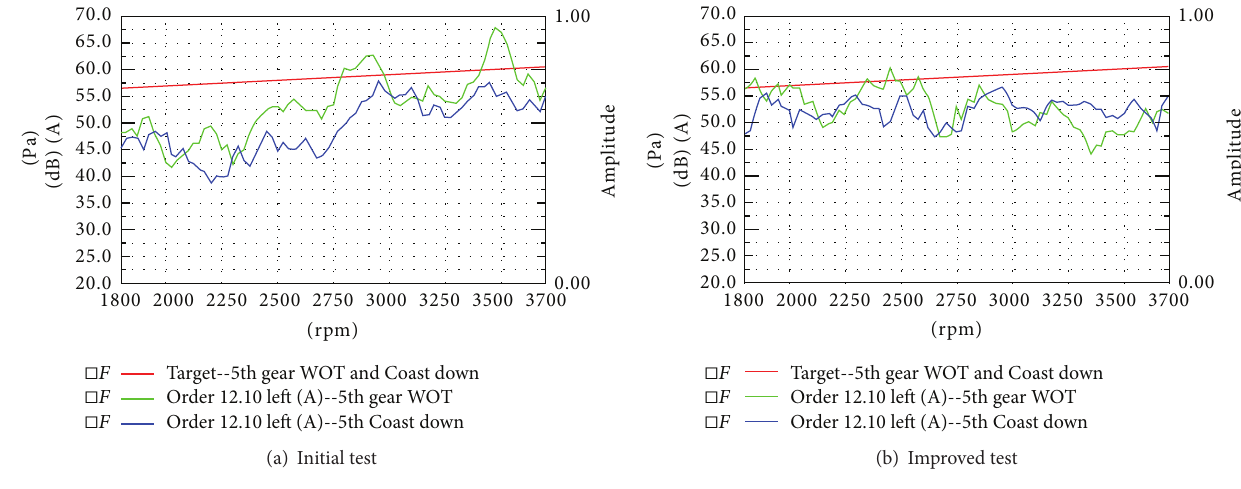
Figure 11: Interior noise test under different